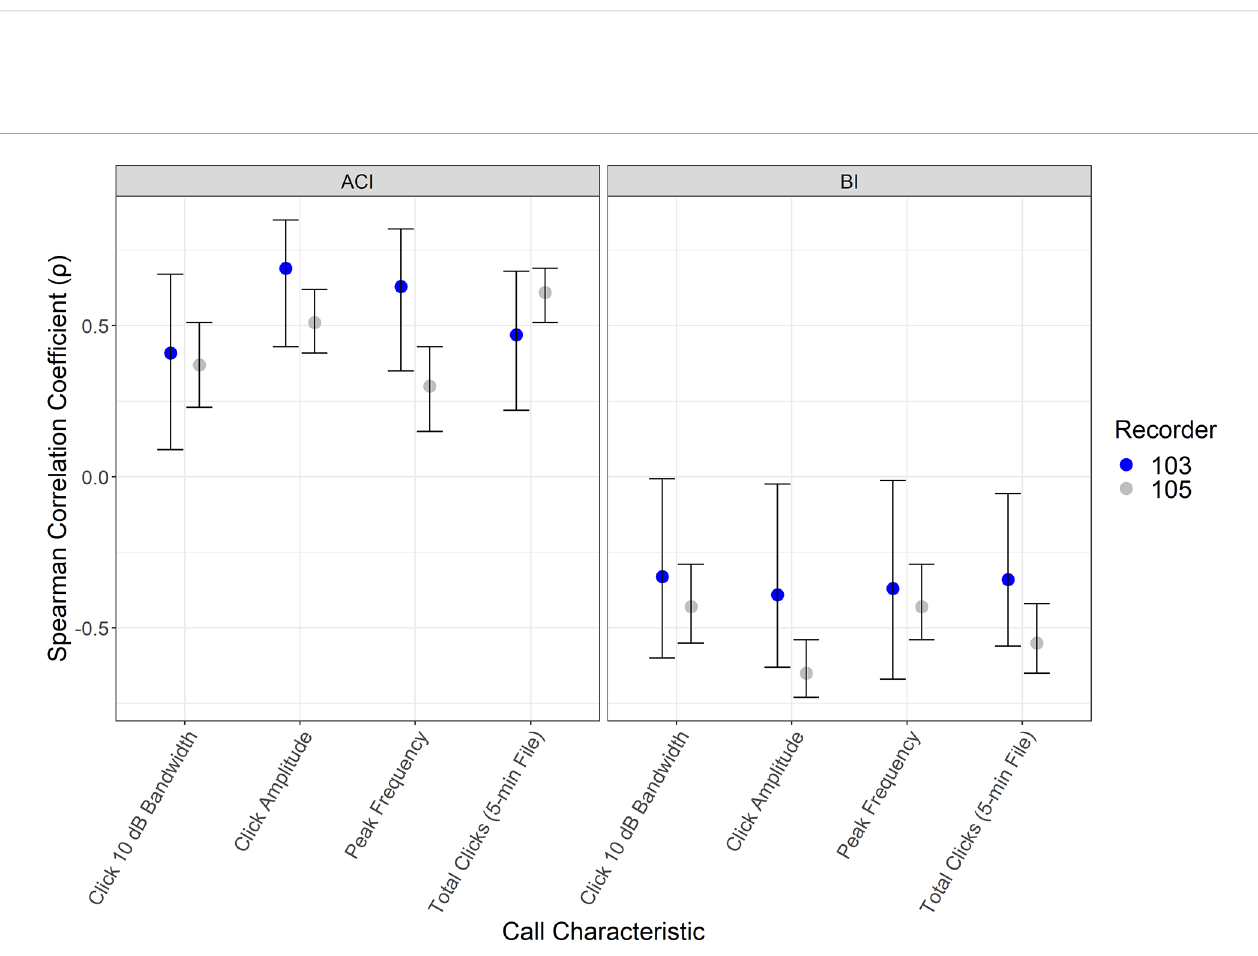
FIGURE 7 Results of the Spearman correlation coef fi cient ( r ) and bootstrapped con fi dence intervals comparing call characteristics of sperm whales to Acoustic Complexity Index and Bioacoustic Index. Mean measurements calculated per 5-minute interval of sperm whale echolocation clicks characteristics including 10 dB bandwidth, click amplitude, peak frequency, and total number of clicks (per 5-min fi le) are reported for the recorder on the base of the slope (103) and the slope